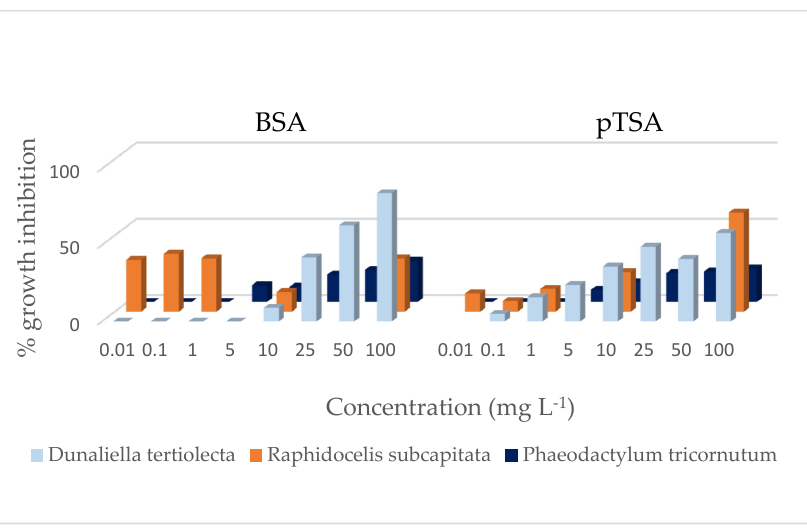
Figure 3. Values of the percentage of growth inhibition produced by the benzenesulfonamides on the three algal species.